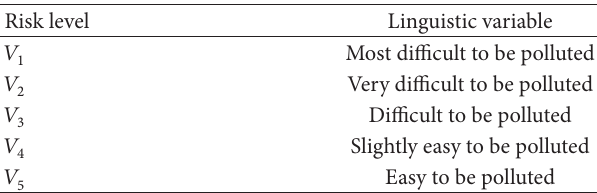
Table 2: Relationship between linguistic variables and risk evalua- tion